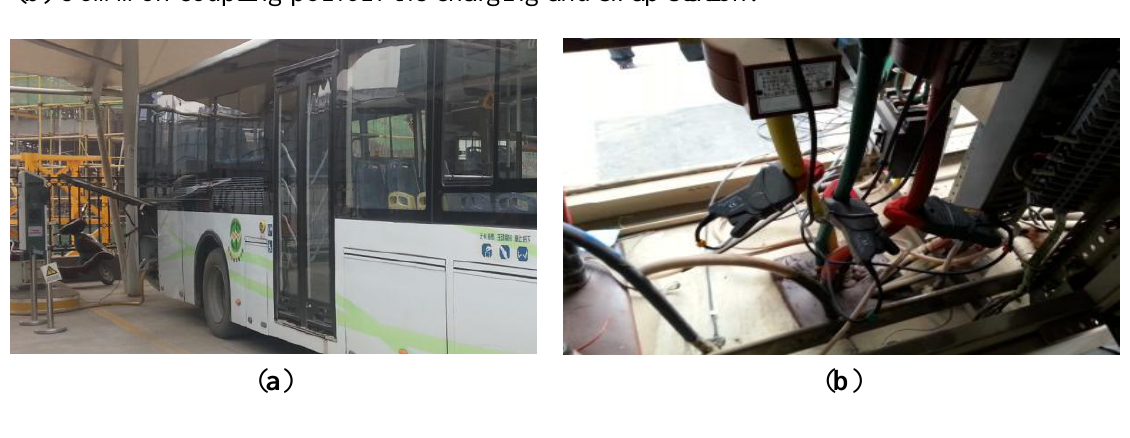
Figure 12. Field test of the bus charging and swap station. ( a ) An electric bus charging; ( b ) Common coupling point in the charging and swap station.